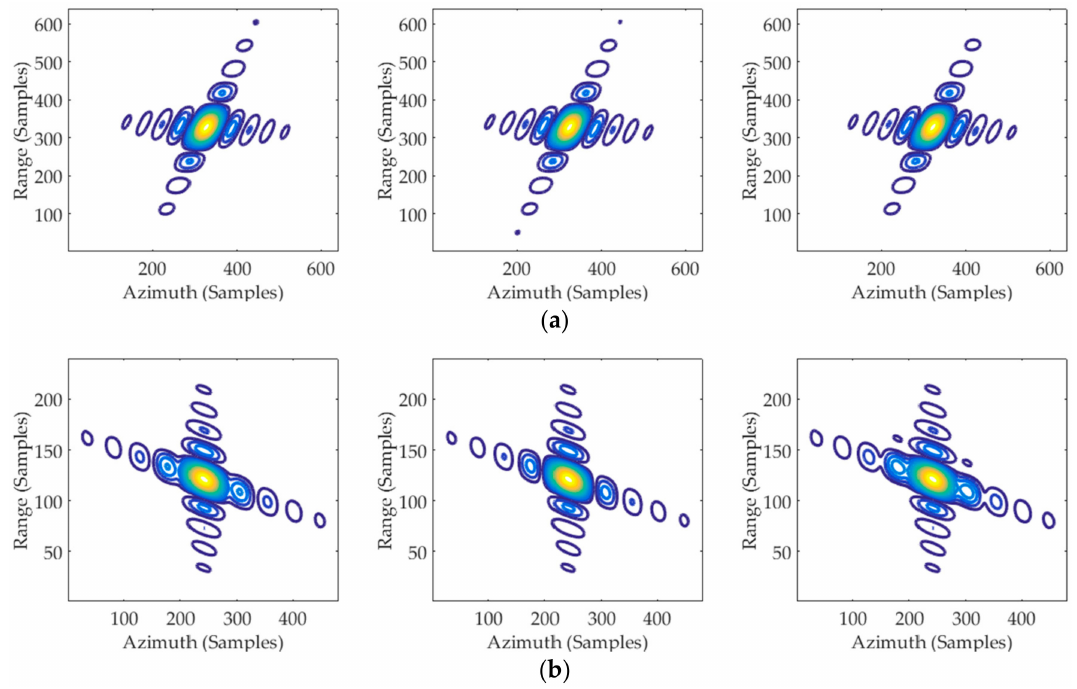
Figure 8. Comparative results by proposed algorithm and CSA. (Left to right) Targets PT1, PT5, and PT9, respectively. ( a ) Contour plot of targets (PT1, PT5, and PT9) processed by the EBP algorithm; ( b ) Contour plot of targets (PT1, PT5, and PT9) processed by